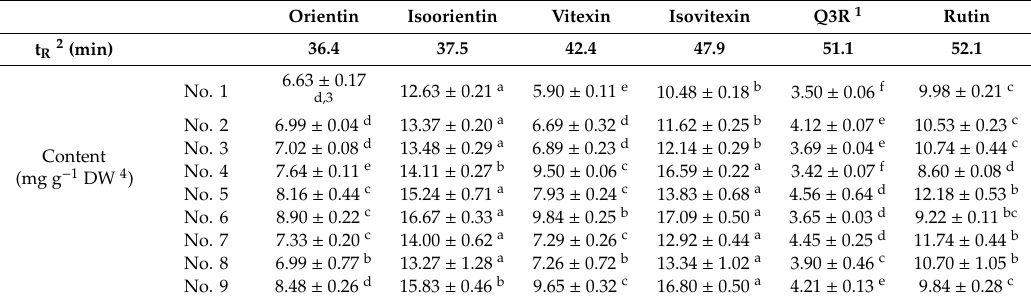
Table 4. Application of the developed HPLC method to common buckwheat sprout extracts. Orientin Isoorientin Vitexin Isovitexin